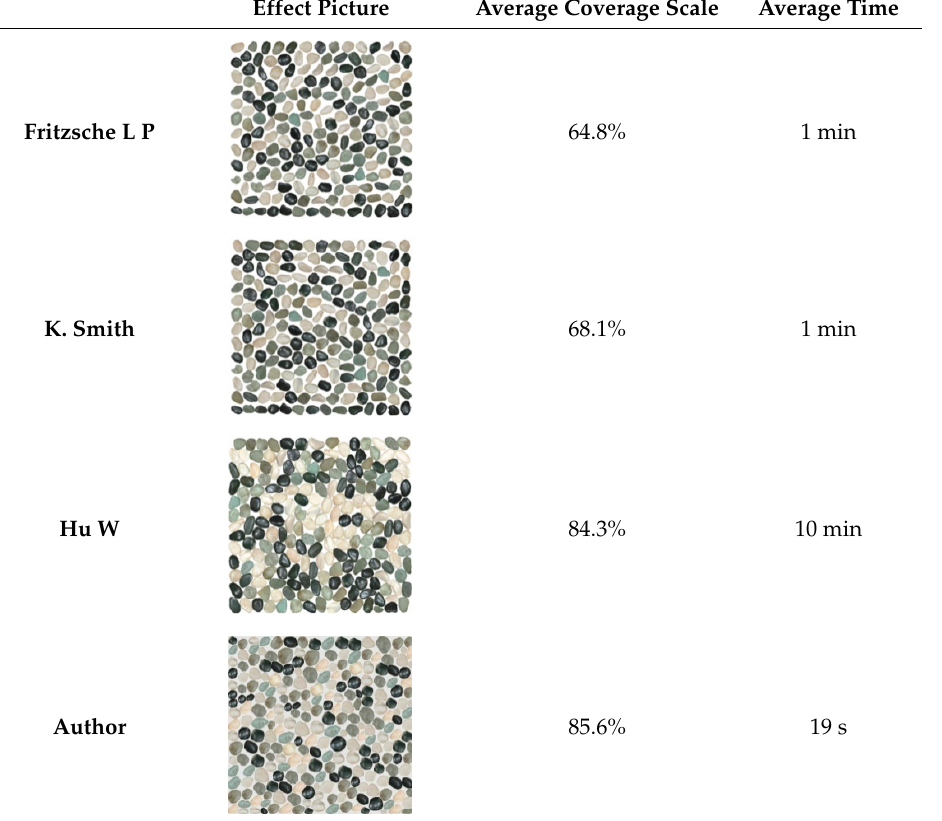
Table 2. Comparison among different methods.